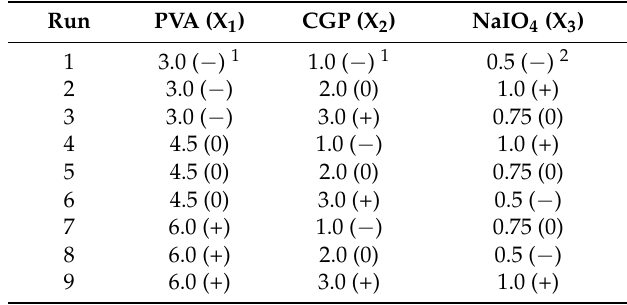
Table 1. Factors coded (in parenthesis) and decoded levels used in the 3 3-1 fractional factorial design to produce CGP/PVA